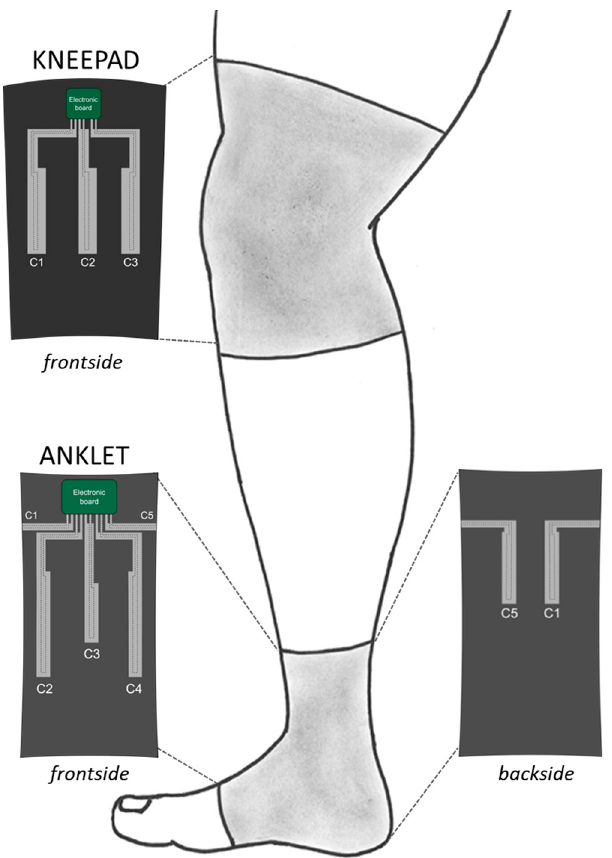
Figure 2. Schematic showing a sketch of a human lower limb with the design of knee and ankle modules integrating a sensing part with a specific layout, and an electronic readout system.